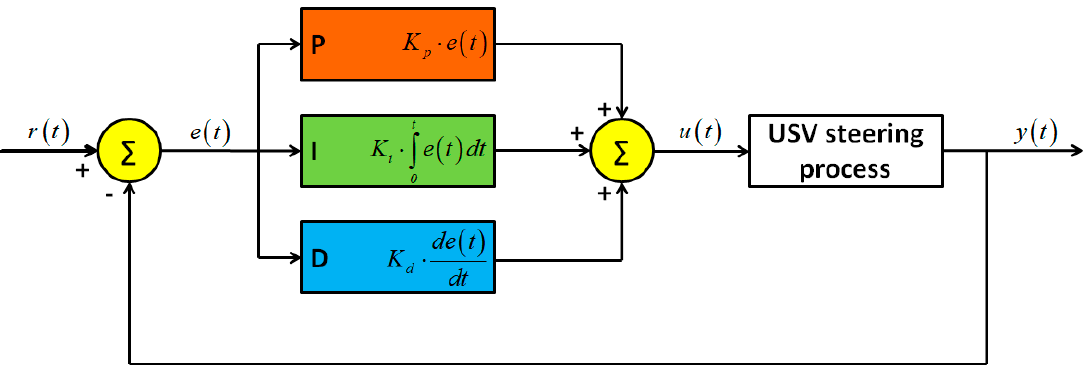
Figure 3. USV autopilot steering process. Own study based on [28].